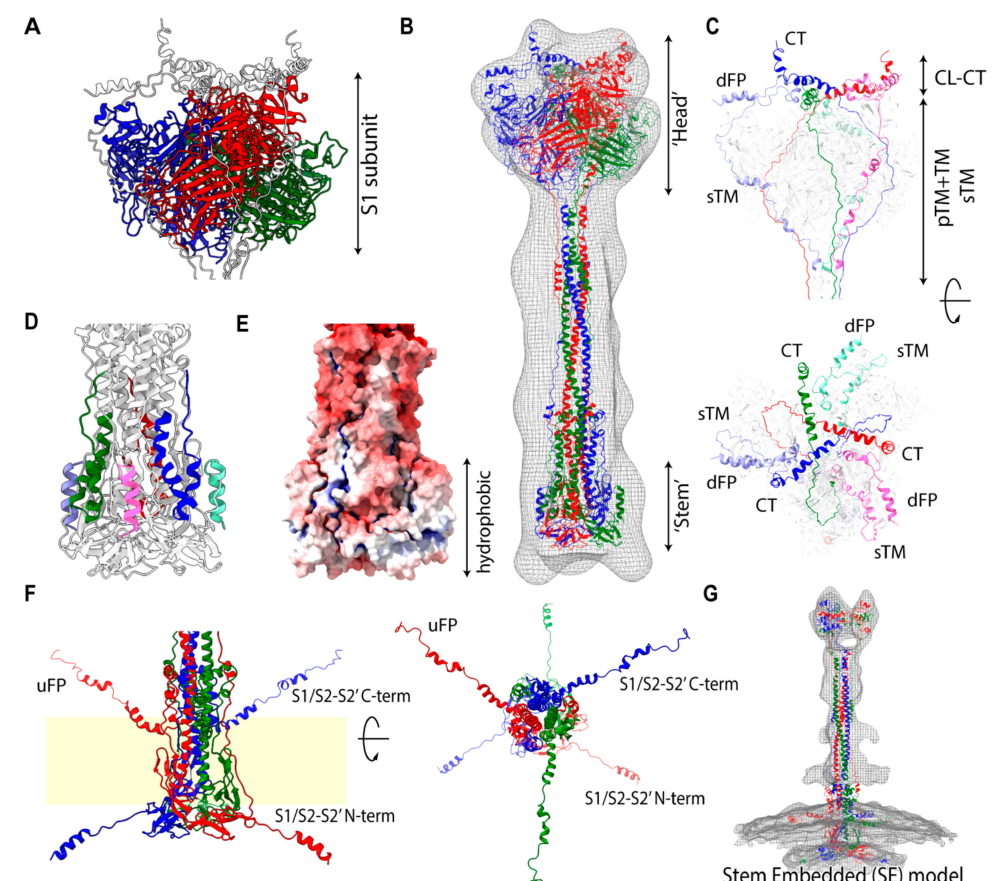
Figure 3. Computational model of the POST state structure. ( A ) A close-up of the previously uninterpreted region occupied by the S1 trimer. ( B ) Overview of the POST structure in solution fitted into the low-resolution Cryo-EM map. ( C ) A close-up of strands wrapping around the S1 trimer, with dFP + CL + sTM (light RGB) and pTM + TM + CT (RGB) shown. ( D ) Modeled fragments applied for disordered regions, N-term (light RGB), and C-term (RGB) of S1/S2-S2 (cid:48) subunit. ( E ) Electrostatic potential of the stem (red: positive; blue: negative). ( F ) Both terms of S1/S2-S2 (cid:48) are presumed to be extended. In the presence of the viral membrane, S1/S2-S2 (cid:48) terms are presumed to extend along the surface of the membrane. A similar image was obtained using the Cryo-EM in moderate detergent. ( G ) Putative stem-embedded (SE) model fitted into the virion Cryo-ET map. The ‘Head’ region, having a large cavity, can be filled with transmembrane segments (TM, pTM, sTM), cytoplasmic segments (CT, CL), and dFP, but without the S1